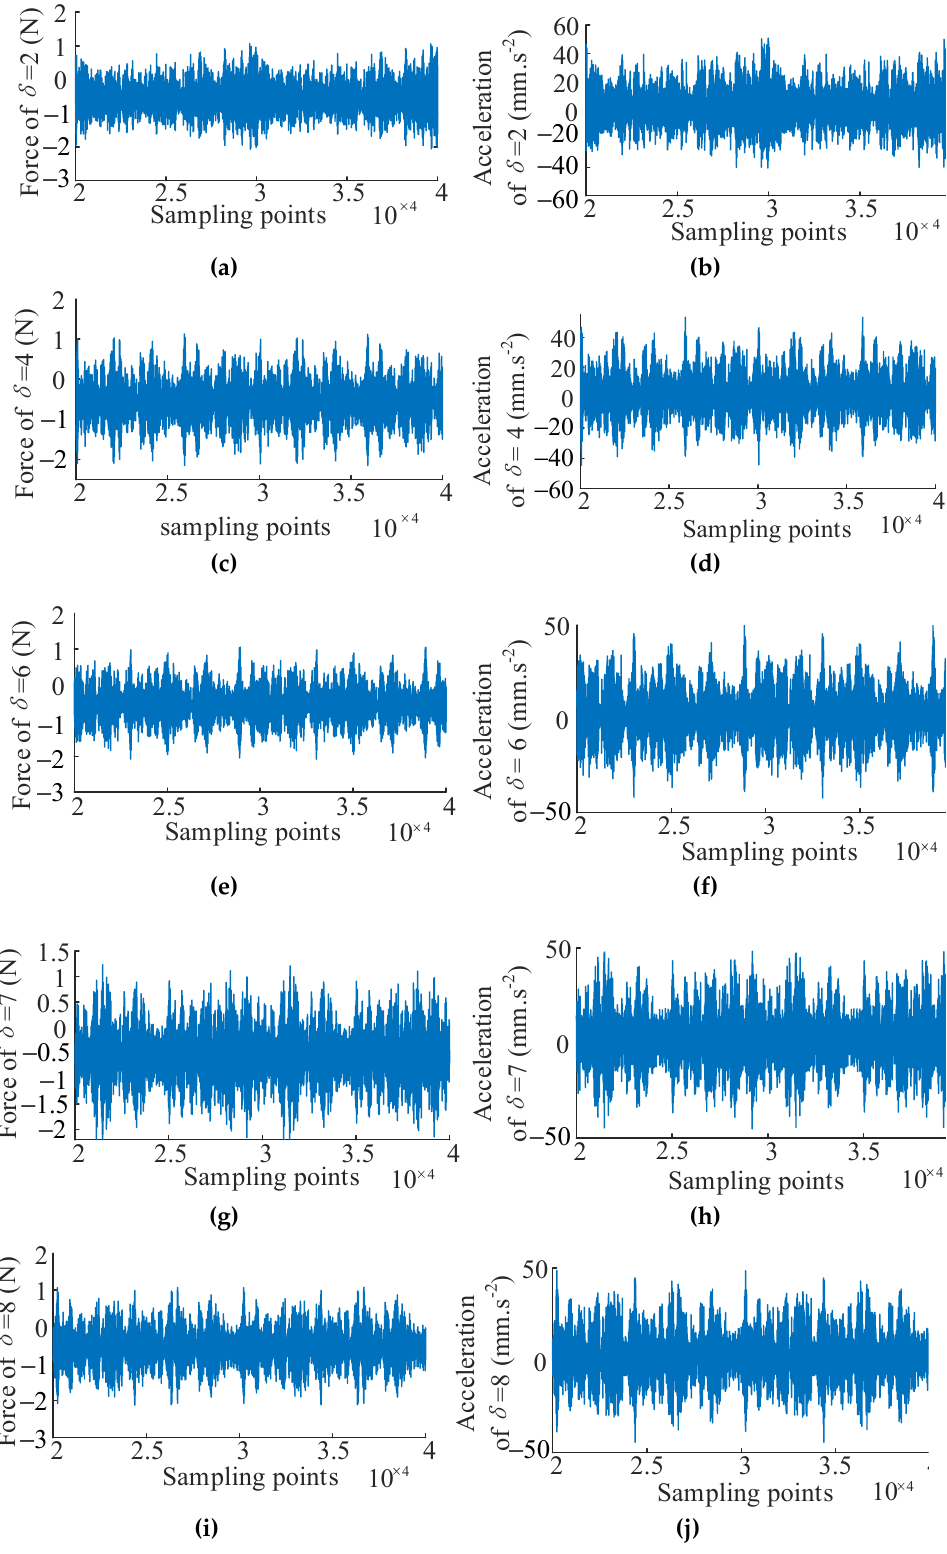
Figure 8. Input and output signals for modeling and validation. ( a ) Input signal of δ = 2 Nm; ( b ) output signal of δ = 2 Nm; ( c ) Input signal of δ = 4 Nm; ( d ) output signal of δ = 4 Nm; ( e ) Input signal of δ = 6 Nm; ( f ) output signal of δ = 6 Nm; ( g ) Input signal of δ = 7 Nm; ( h ) output signal of δ = 7 Nm; ( i ) Input signal of δ = 8 Nm; and ( j ) output signal of δ = 8 Nm. In the experimental case, the maximum time lags for both the input and output signals were chosen to be n u = 3 and n y = 3, respectively. The order of the nonlinearity is selected as l = 3, and the CMS of the bolted joint system identified by using the EFOR